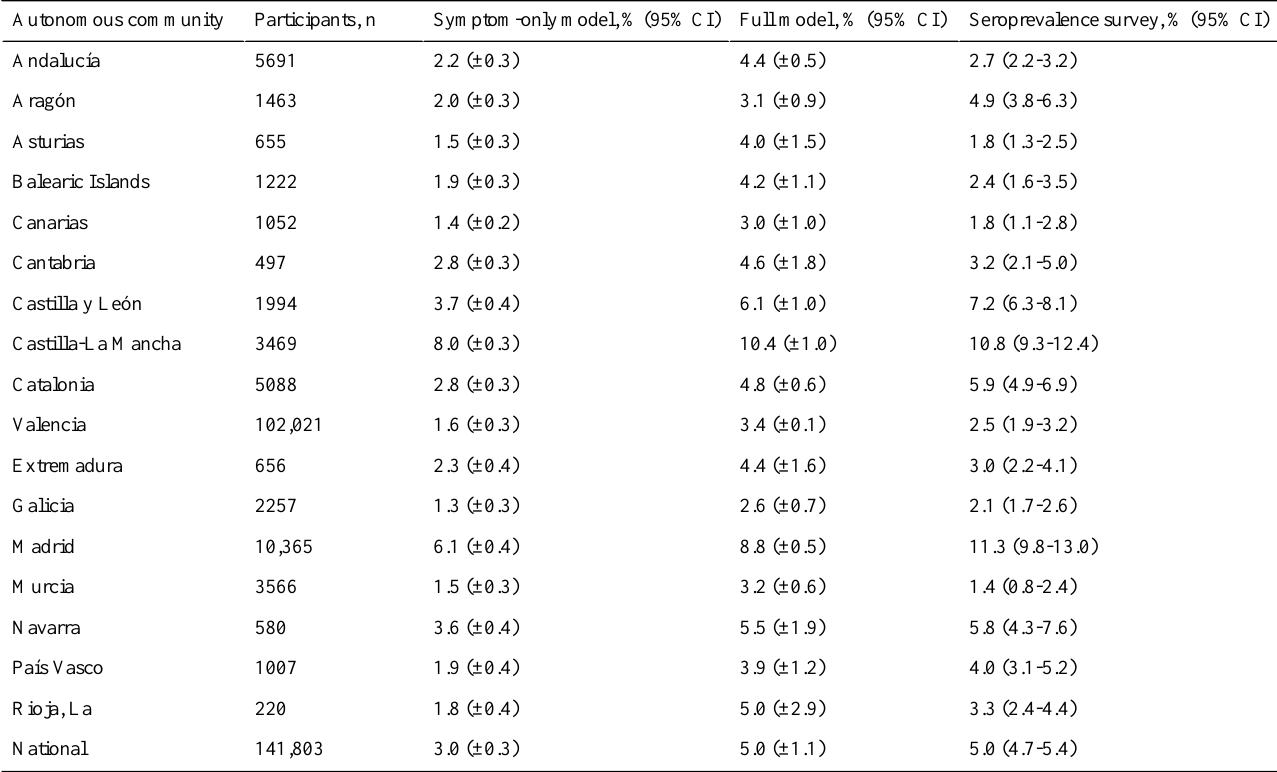
Table 5. Comparison of inferred prevalence by two models based on the survey answers and the seroprevalence